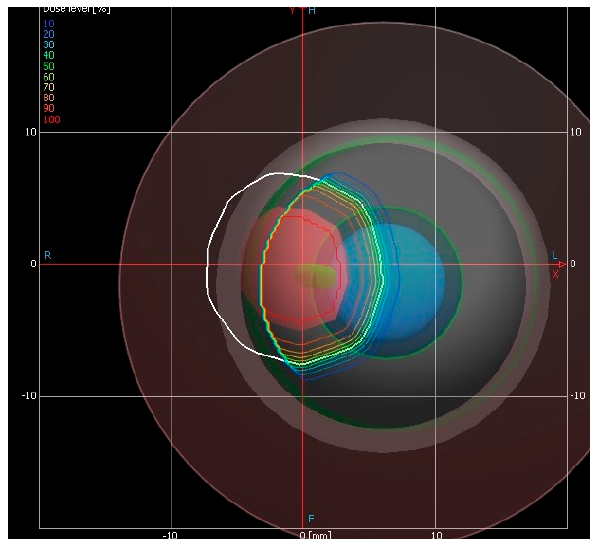
Figure 2. Beam ‐ axis isodose view from the Eyeplan Treatment Planning System. Figure 2. Beam-axis isodose view from the Eyeplan Treatment Planning